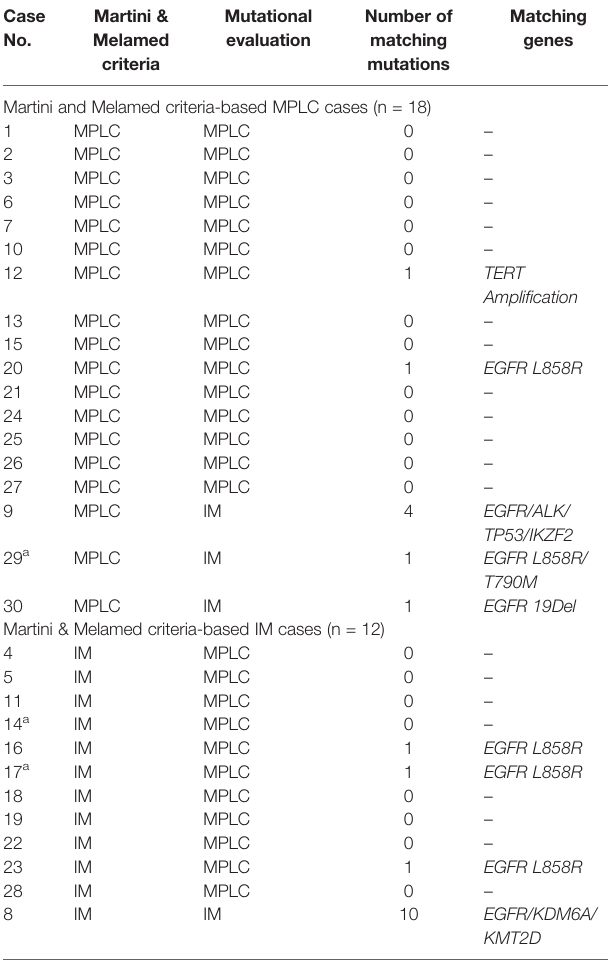
TABLE 2 | Patients with MLC classi fi ed by the Martini and Melamed criteria and molecular methods. Case Martini & No.